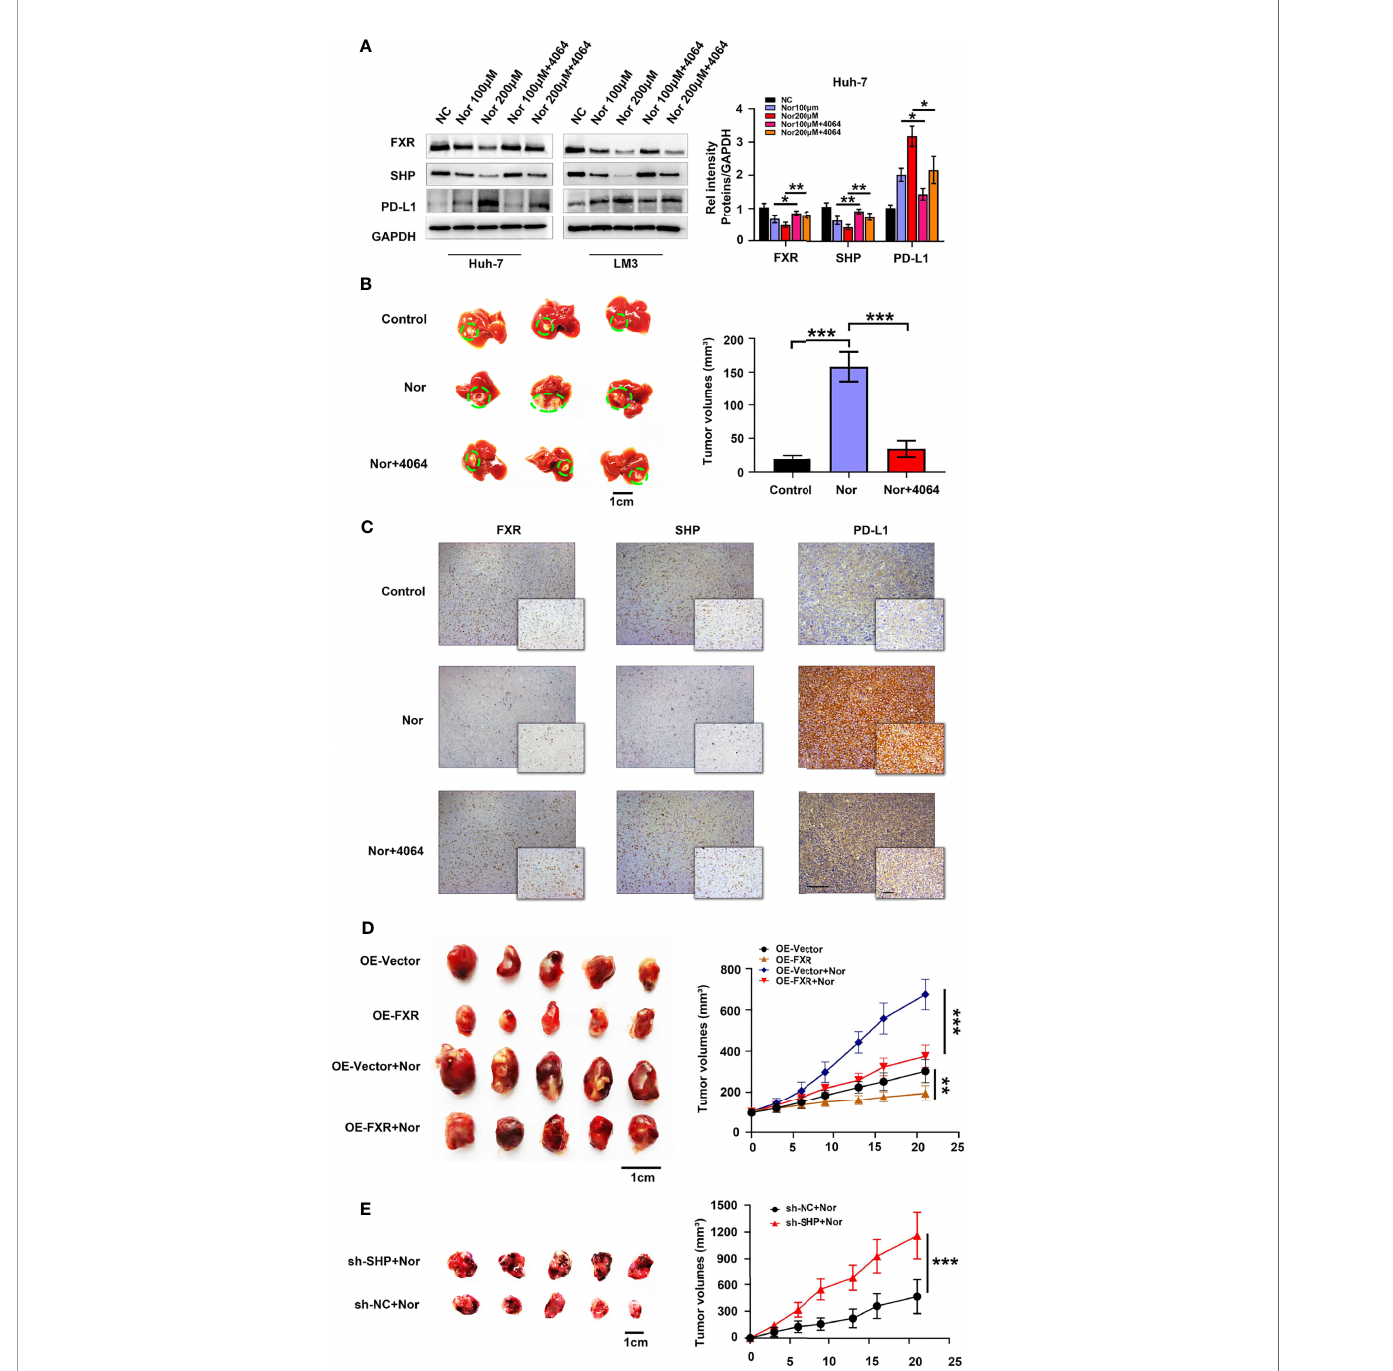
FIGURE 3 | NorCA contributes to tumor growth and tumorigenicity via FXR-SHP-PD-L1 signaling. (A) Left graph, the FXR, SHP, and PD-L1 levels in Huh-7 and LM3 cells were detected by western blot analysis. Right graph, gray value analysis of all proteins. (B) Left graph, schematic representation of the orthotopic implantation formed by Hep1-6 cells. Mice treated with PBS (n=5), NorCA alone (n=5) or NorCA plus GW4064 (n=5). Right graph, quanti fi cation of tumor volumes in different groups. (C) Typical pictures of FXR, SHP and PD-L1 staining in orthotopic implantation models (Large fi gure: 200× magni fi cation, scale bar, 100 µm. Small fi gure: 400× magni fi cation, scale bar, 100 µm). (D) Left image, comparing the tumor volume of OE-FXR mice (n=7) with the tumor volume of OE-Vector (n=7) mice with or without NorCA treatment. Right graph, quanti fi cation of the tumor volumes in different groups. (E) Left graph, Hep1-6 cells with or without SHP knocked down were subcutaneously injected into mice. Tumor volumes in the SHP-knockdown group (n=5) was obviously higher than that in the control group (n=5). Right graph, quanti fi cation of tumor volumes of different groups. *p < 0.05, **p < 0.01, and ***p <